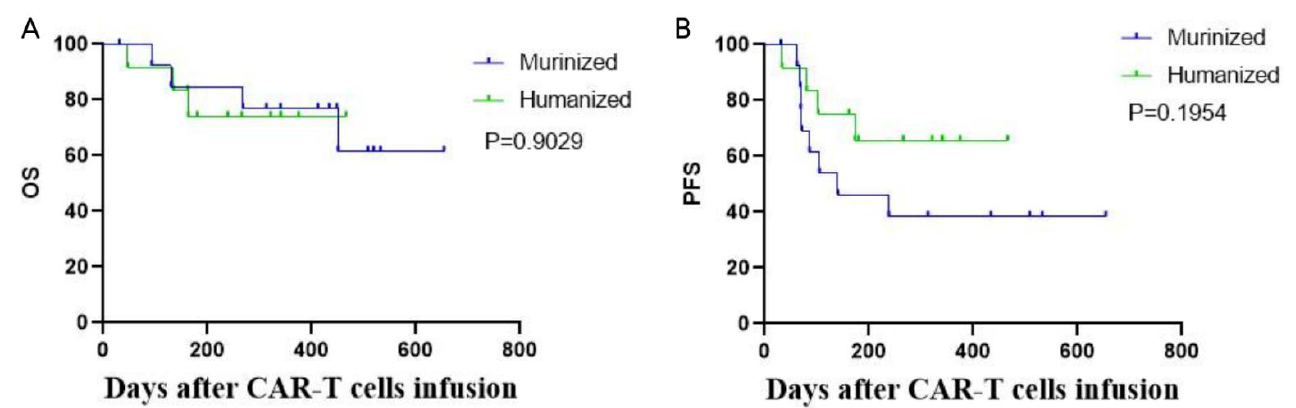
Figure 3. Survival curve comparison between the murinized and humanized groups. ( A ) No difference in overall survival between the murinized and humanized groups; median OS not achieved in either group. ( B ) Trend towards better PFS in the humanized compared to the murinized group. ( p = 0.1954). OS: overall survival; PFS: progression-free survival.